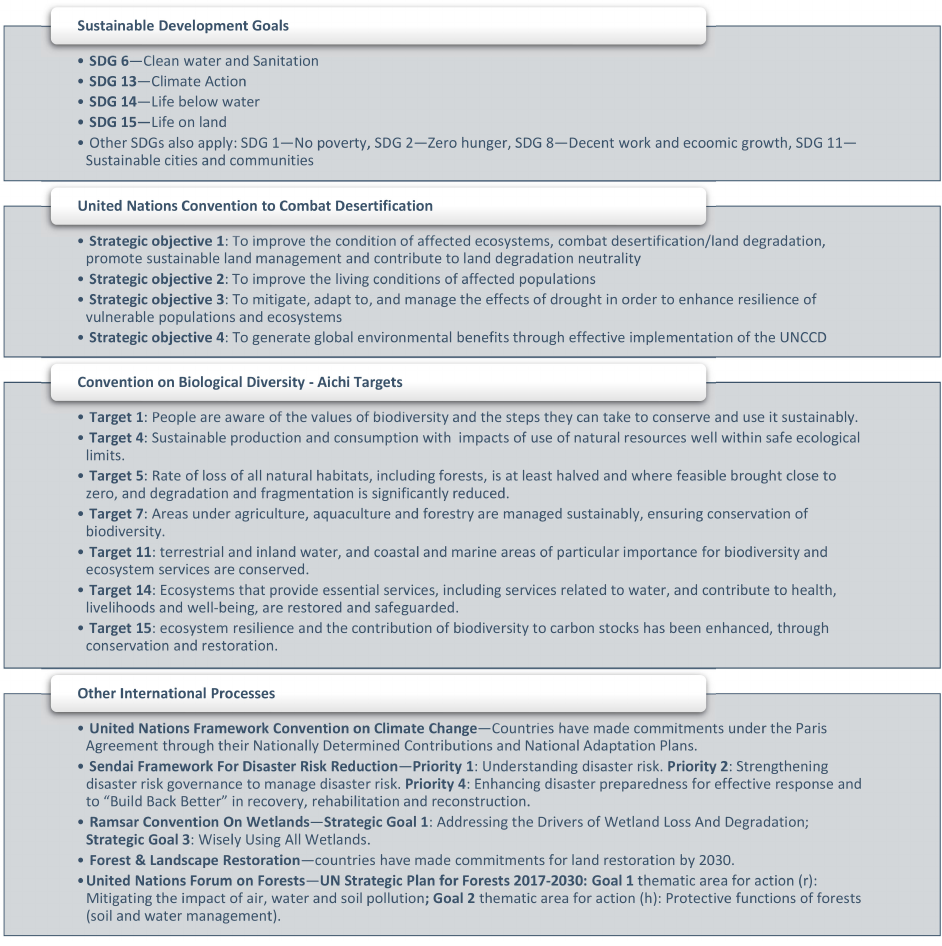
Figure 6. Relevant international political agenda / frameworks to the forest–water